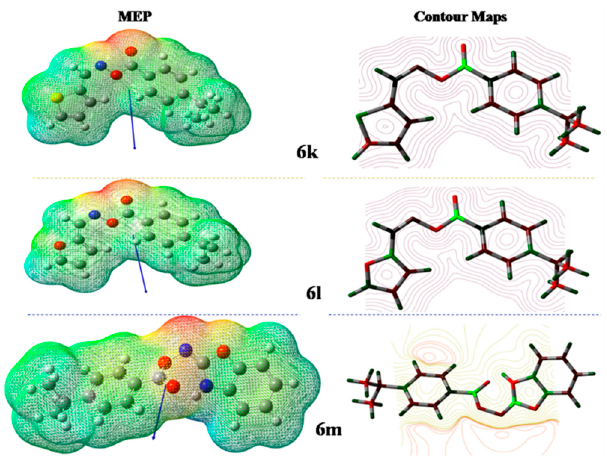
Figure 4. The molecular electrostatic potential and contour maps of compounds 6k , 6l and 6m .